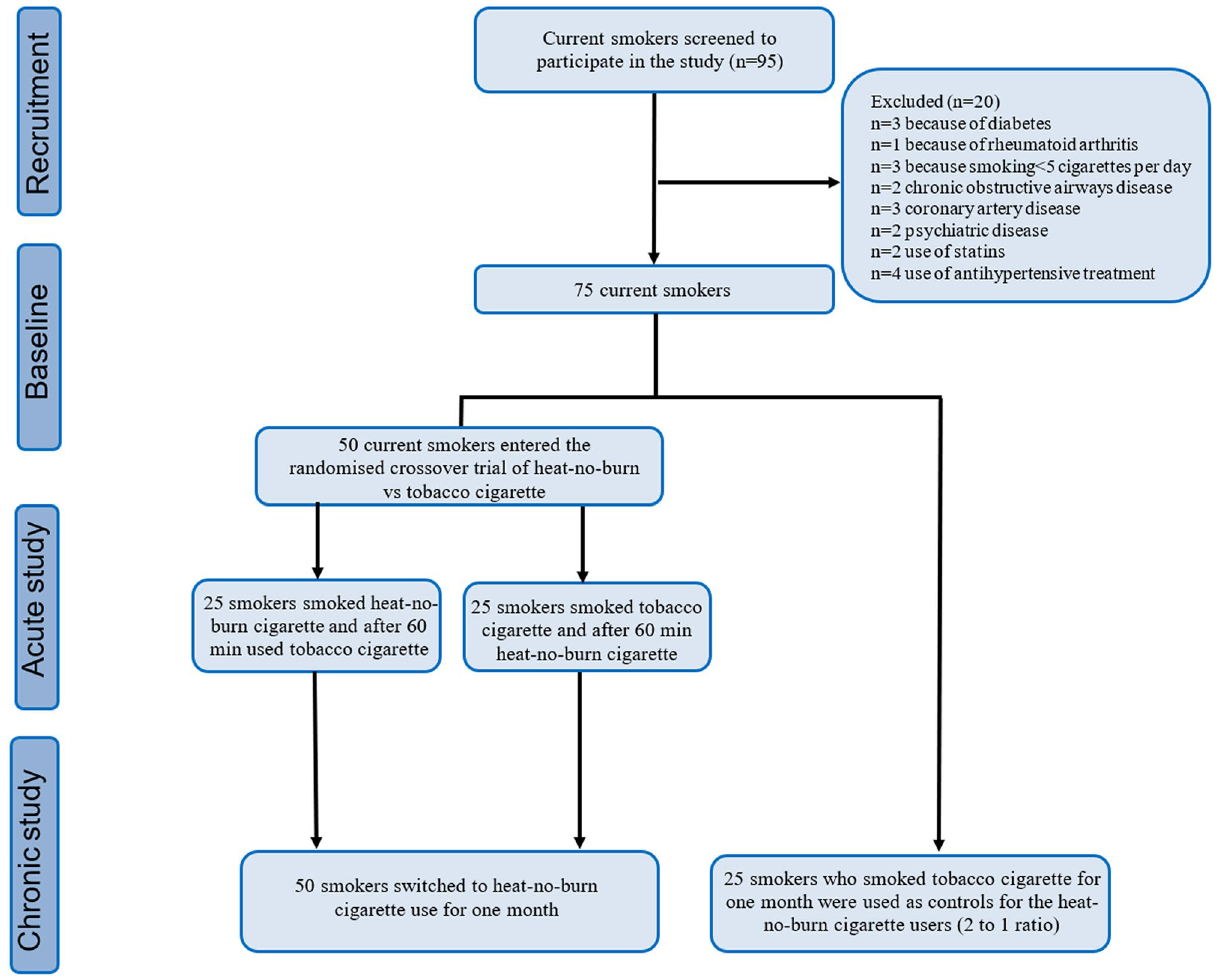
Figure 4. Flow chart of the study population. HNBC heat-not-burn cigarette, TCig tobacco